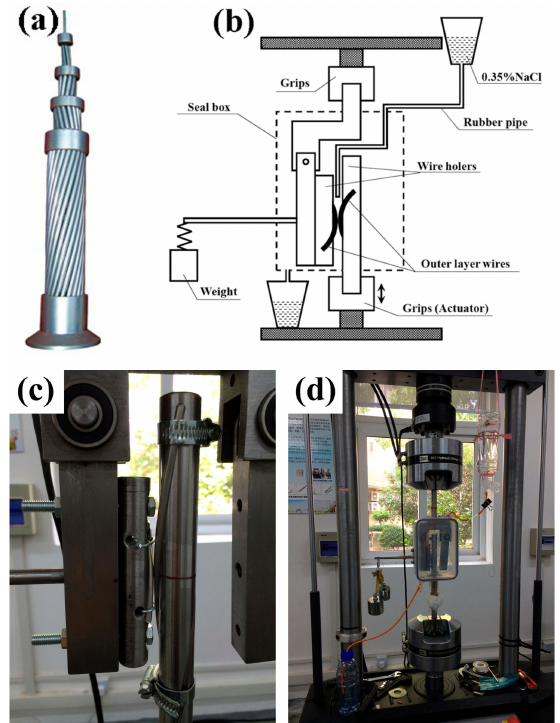
Figure 1. The test apparatus based on MTS 370.10: ( a ) ACSR 630/45; ( b ) schematics; ( c , d ) photos for the actual